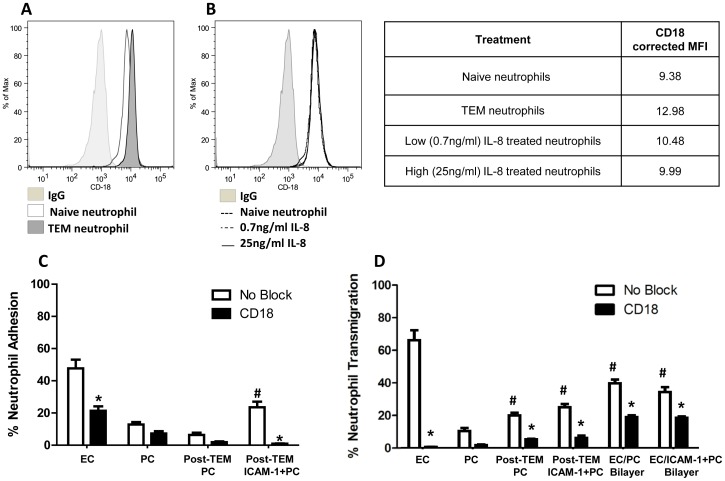
CD18-dependent post-transendothelial migration.(A) CD18 (β2 integrin) expression on naïve and transendothelial migrated (TEM) neutrophils (across 4 hr IL-1β activated EC monolayers) and (B) naive 0.7 ng/ml IL-8 and 25 ng/ml IL-8 stimulated neutrophils assessed by flow cytometry. Table 1. Corrected mean fluorescent intensity (MFI) reflect CD18 expression from flow cytometry. (C) Neutrophil adhesion on EC, PC, post-TEM PC, or post-TEM ICAM-1+PC monolayers following 4 hr IL-1β activation. Freshly isolated neutrophils were pre-incubated with anti-CD18 antibodies and seeded onto the monolayers in Sykes-Moore chambers and allowed to adhere prior to counting. Bars represent average neutrophil adhesion ± SEM. *P<0.05, when compared to no block EC control. (D) Neutrophil transmigration across EC, PC, post-TEM PC or post-TEM ICAM-1+PC monolayers, and EC/PC bilayer or EC/ICAM-1+ PC bilayer following 4 hr IL-1β activation. Freshly isolated neutrophils were pre-incubated with anti-CD18 antibodies and seeded onto the Transwell monolayers and allowed to transmigrate for 1 hr. Bars represent average neutrophil transmigration ± SEM. *P<0.05, when compared to no block control of the same cell layer(s). #P<0.05, when compared to no block EC and PC control.